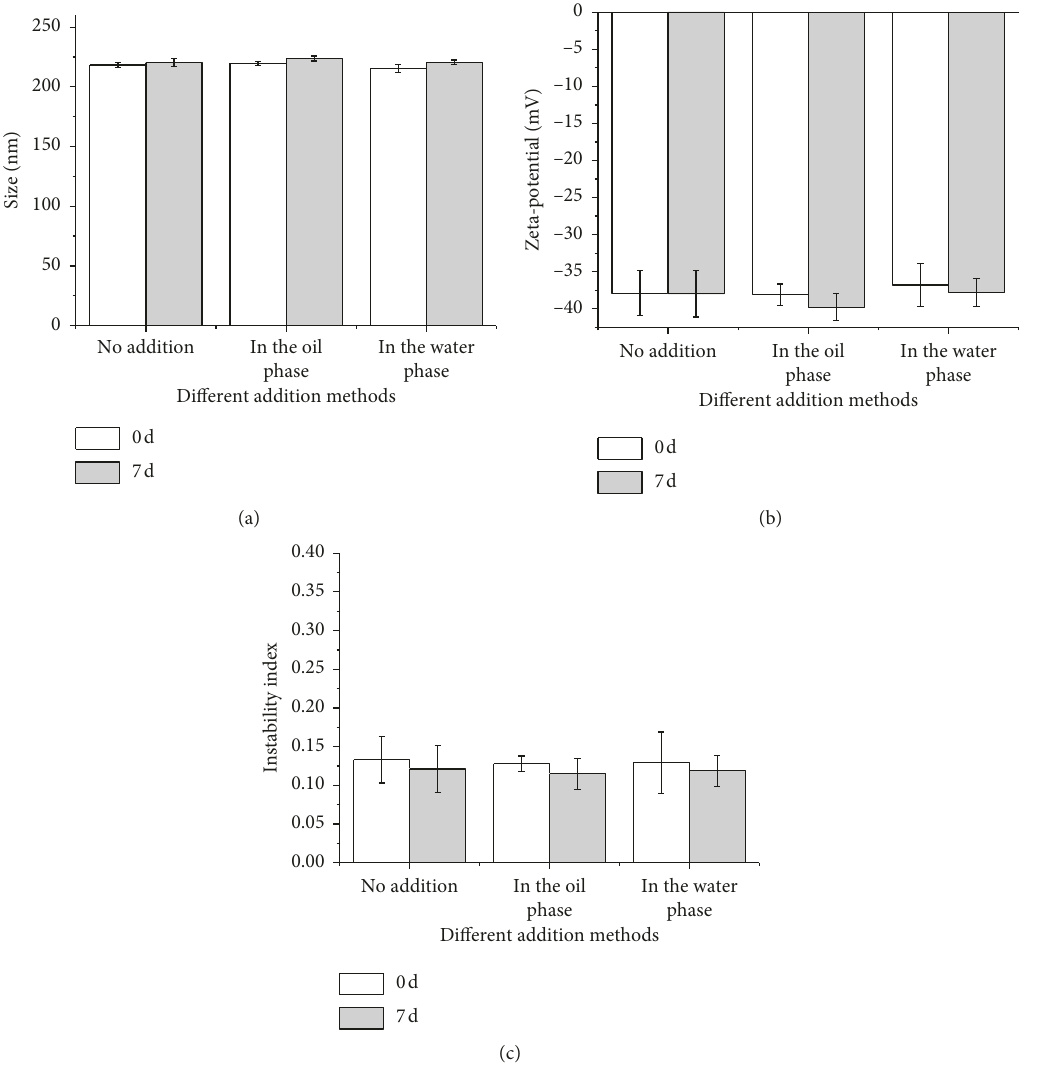
Figure 3: Effect of the rosemary extract (RE) addition in different phases (oil and water phase) on the droplet size (a), zeta-potential (b), and instability index (c) of WPI-stabilized lutein emulsion before storage (0 days) and after storage (7 days) at 55 ° C. Data points represent means ( n � 3) ± standard